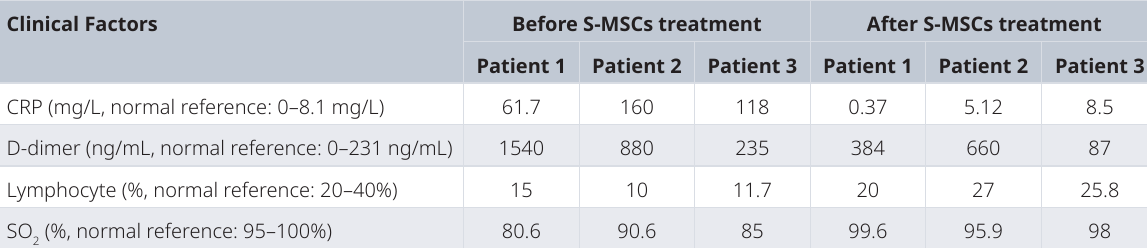
Table 3. Comparison of laboratory parameters before and after S-MSCs